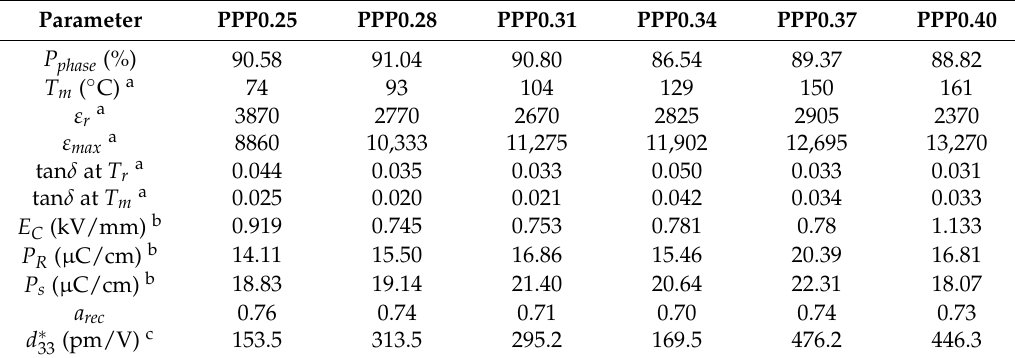
Table 1. The electrophysical parameters of the PMN–PT–PS solid